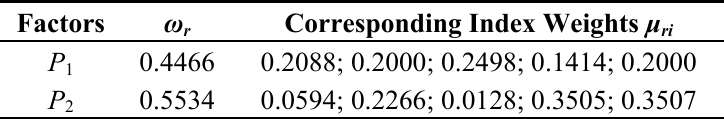
Table 6. Comprehensive weights of factors and indices.